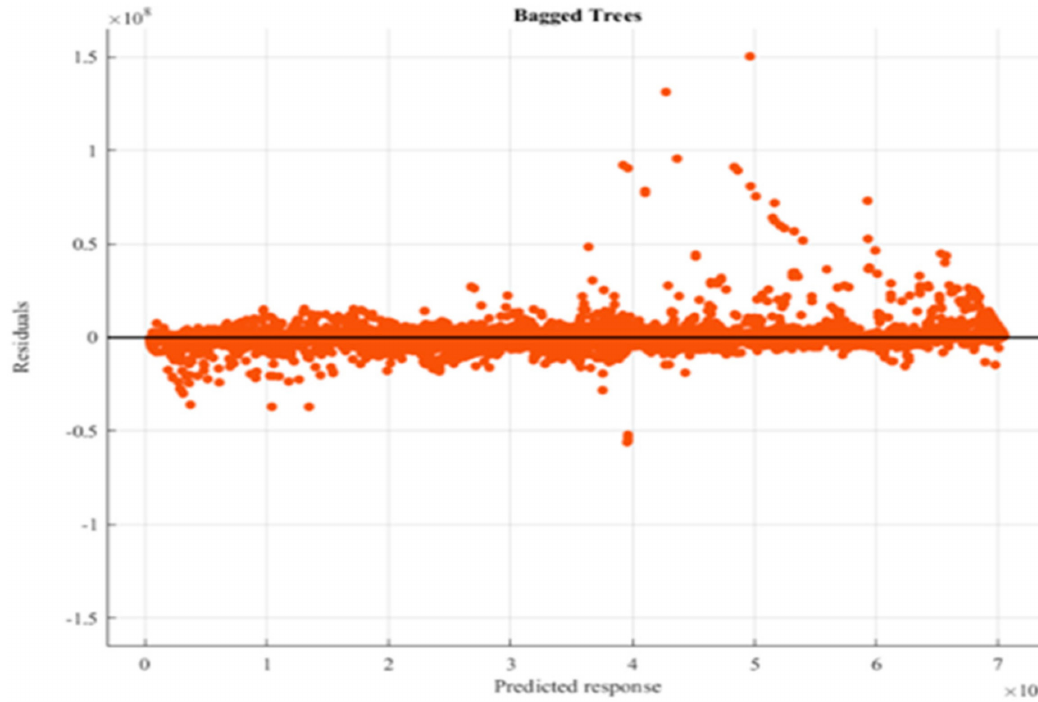
Figure 19. Bagged Trees Residual training.